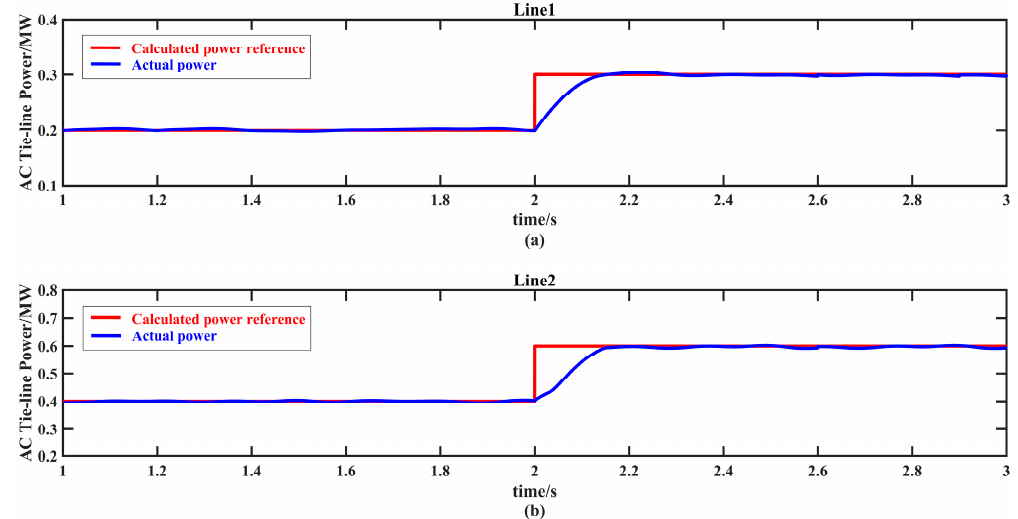
Figure 13. Actual AC tie-line power during the “limited condition” of Battery1. ( a ) AC tie-line 1; ( b ) AC tie-line 2.